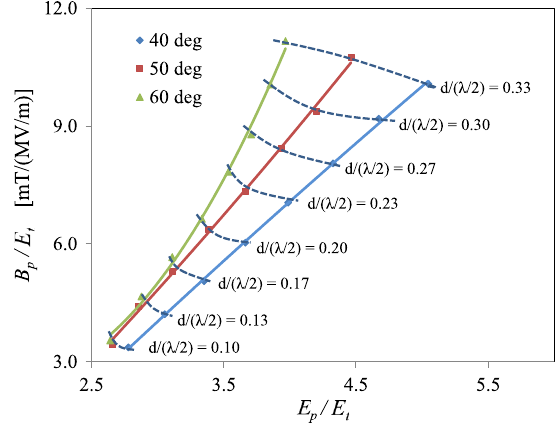
FIG. 33. Ratios of peak surface magnetic field ( B p ) to the electric field ( E p ) with varying beam aperture diameter and angle for rf-dipole design with trapezoidal-shaped bars.